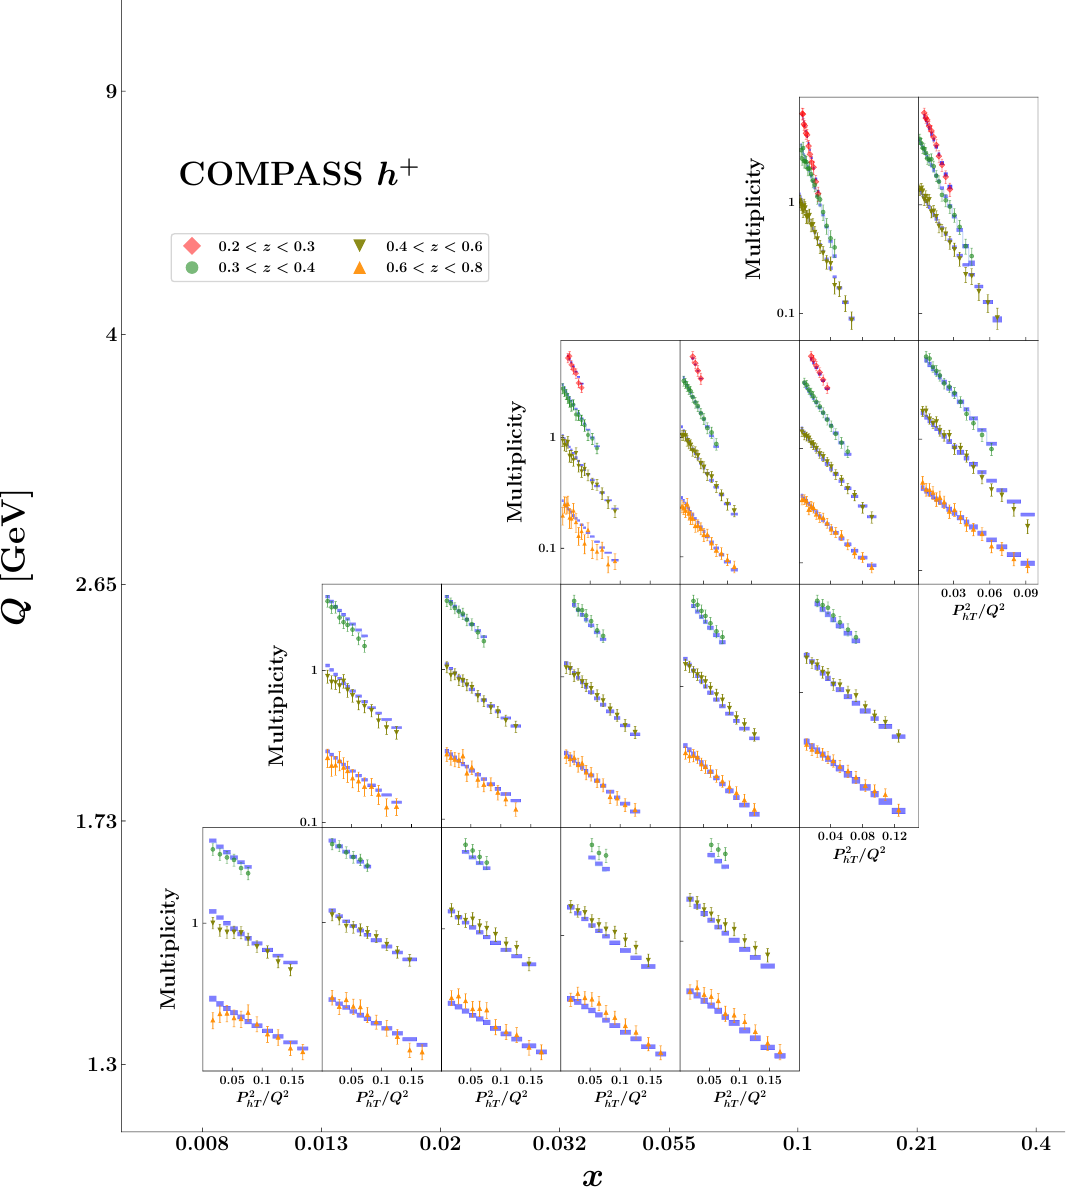
Figure 7 . Same conventions and notation as in previous figure but for unidentified positively charged hadrons off deuteron